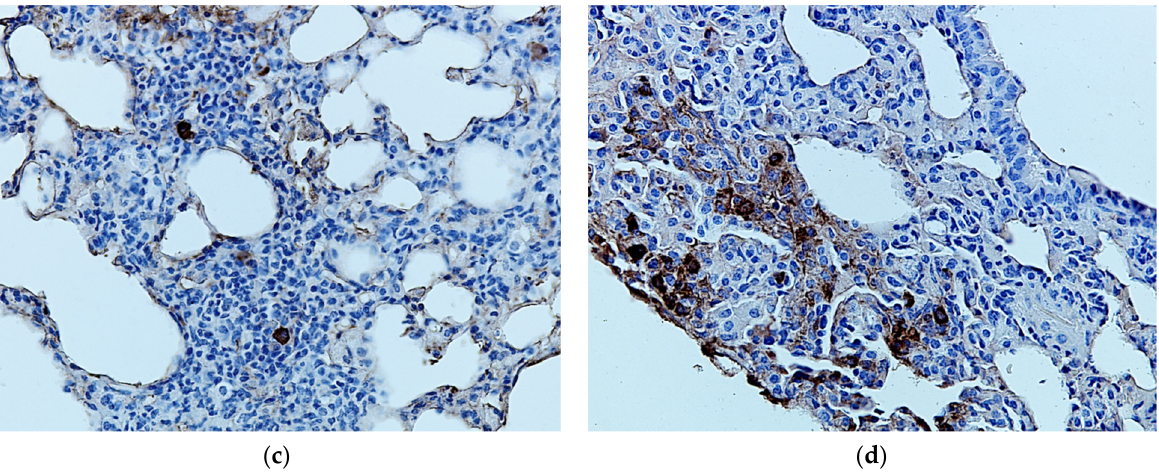
Figure 9. Lung sections. Immunostaining for CD68 + cells and Mayer’s hematoxylin for nuclei, magnification ×400: ( a ) Intact control; ( b ) LPS-control; ( c ) LPS + 5 mg/kg dexamethasone; ( d ) LPS + 30 mg/kg 9g .